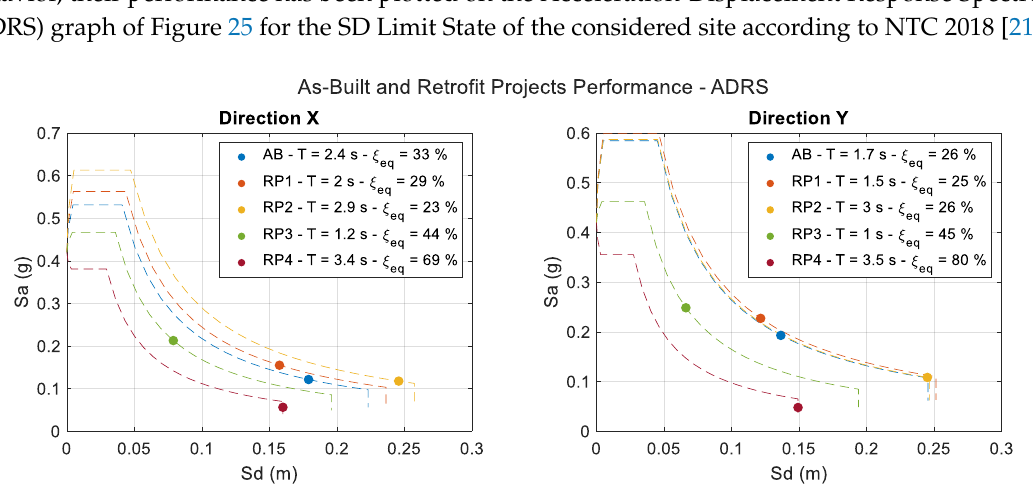
Figure 25. As-Built (AB) and RPs performance Acceleration-Displacement Response Spectrum (ADRS) in X and Y directions.